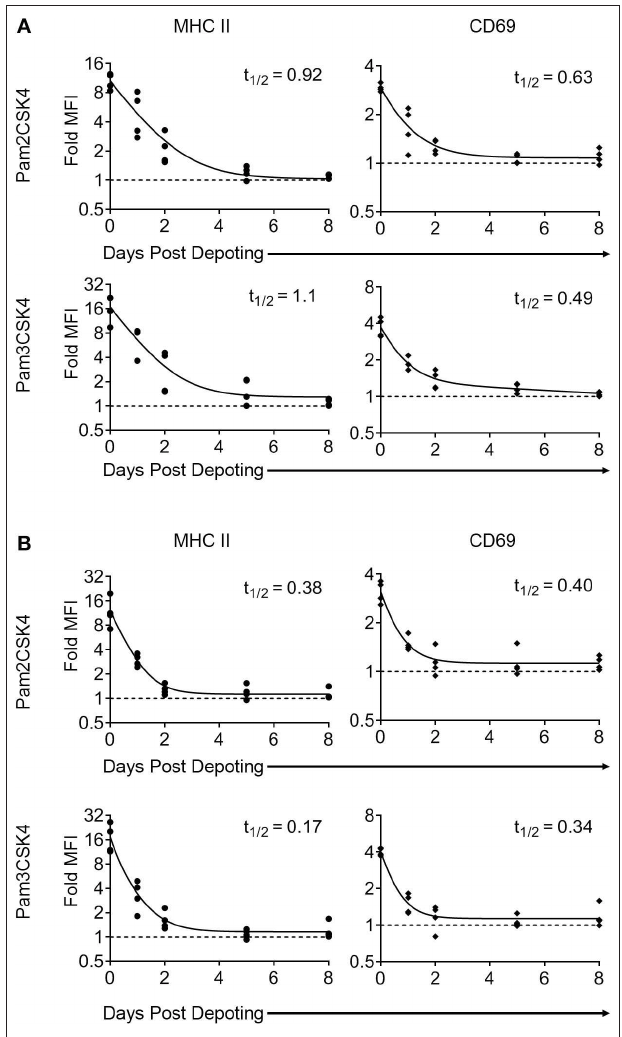
FIGURE 6 | Surface presentation of depoted TLR2 ligands on T cells is non-permanent. Splenocytes were cultured either (A) (as naïve T cells) in absence of, or (B) (as primed T cells) in presence of 2 µ g/mL of Concanavalin A and 10ng/mL of IL-7 for 2 days. Purified T cells were then depoted with either Pam2CSK4 or Pam3CSK4 for 1h at 37 ◦ C in supplemented RPMI media. T cells were then rested in IL-7 for 0, 1, 2, 5, or 8 days. At each time-point, cells were fixed and co-cultured for 2 days with purified B cells. B-cell activation was determined by fold MFI of MHC II (circle) and CD69 (diamond) with respect to unstimulated controls. Dashed line represents theoretical no activation (MFI = 1). Solid lines are two-phase decay non-linear regression curves as determined by independent samples shown. Effective fast half-life in days (t 1 / 2 ) as shown. n = 3–4 independent samples.